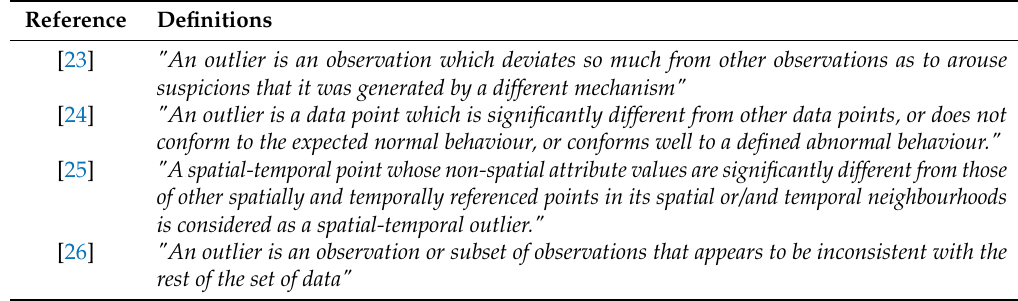
Table 1. Definitions of sensor outliers in the IoT